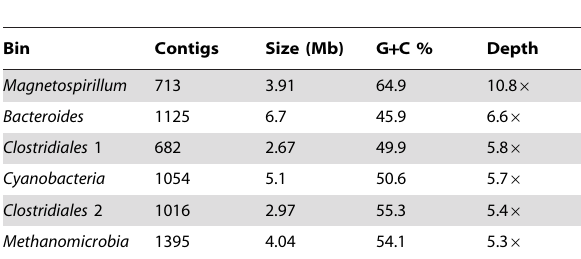
Table 2. Microbial representation from the decomposing poplar wood